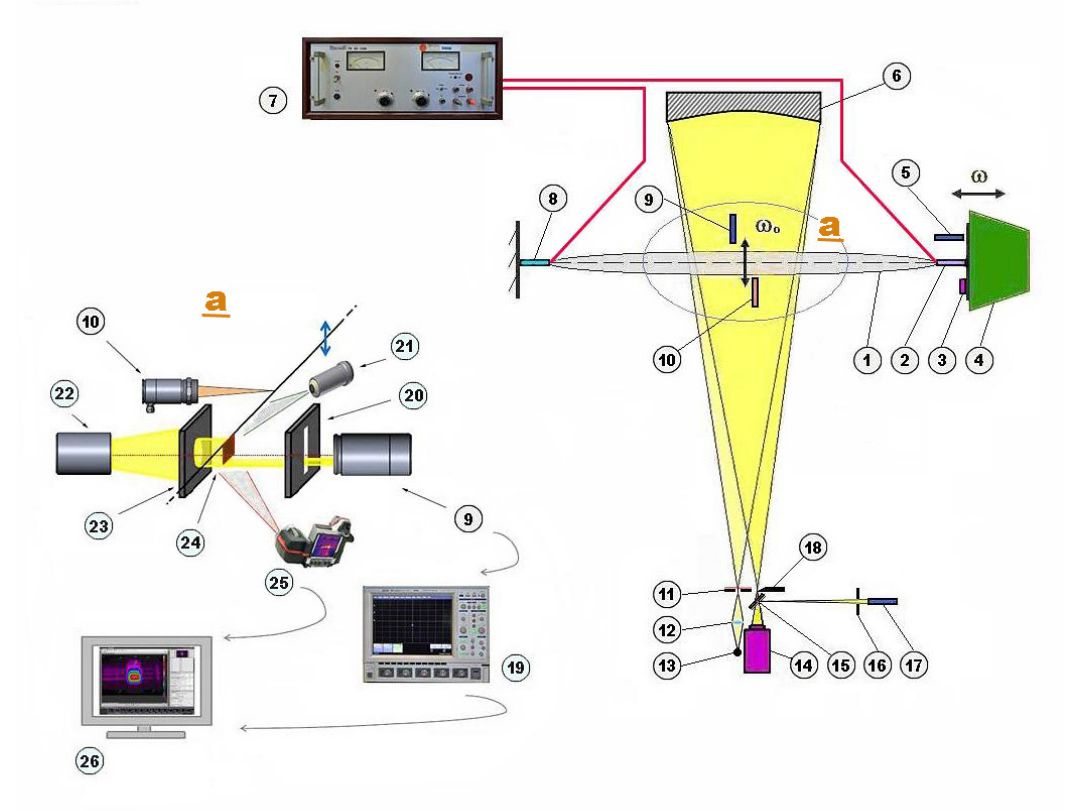
Figure 1. The overview scheme of the experimental installation. 1 —wire heater; 2 —micrometer worm mechanism; 3 —longitudinal accelerometer; 4 —low-frequency loudspeaker’s head; 5 —photomultiplier; 6 —parabolic mirror; 7 —DC source, 8 —quartz force sensor; 9 —photomultiplier; 10 —infrared thermometer; 11 —iris diaphragm with red filter, 12 —lens; 13 —point light source; 14 —digital photo-camera; 15 —translucent mirror; 16 —slit diaphragm; 17 —photomultiplier; 18 —Foucault’s knife; 19 —oscilloscopes; 20 —slit diaphragm; 21 —microscope USB-camera; 22 —light source; 23 —iris diaphragm; 24 —light beam shattering flag; 25 —infrared photo-camera; 26